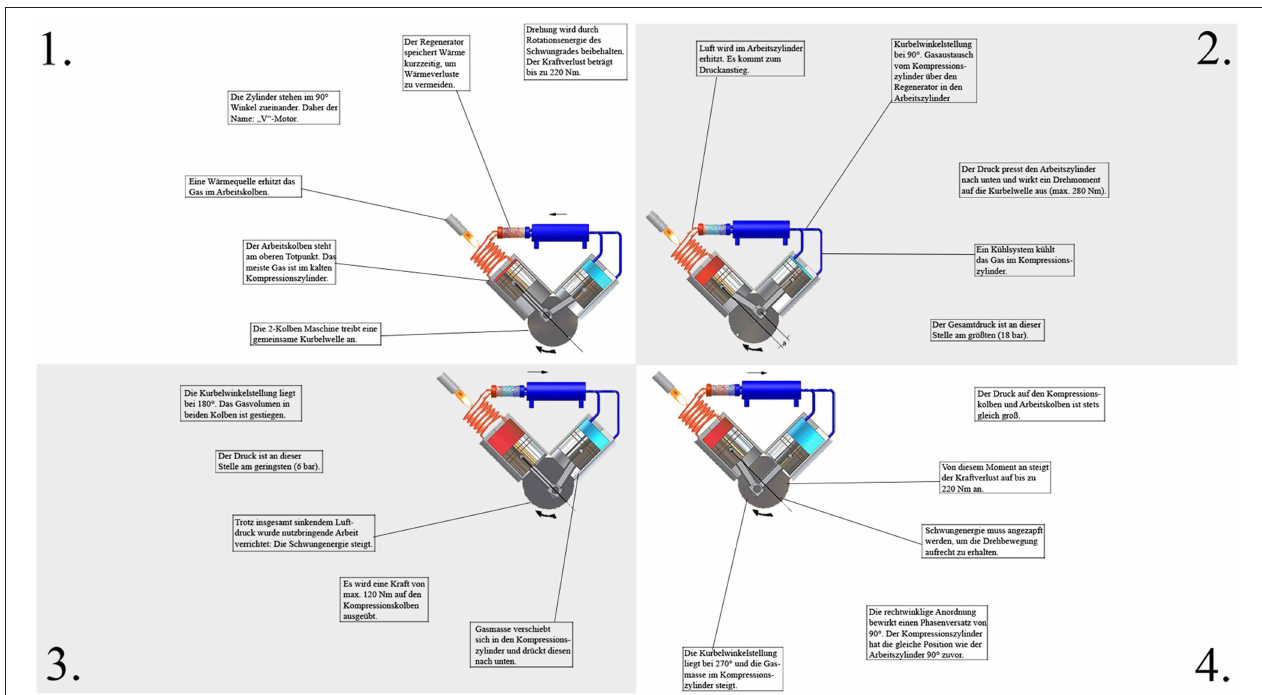
FIGURE 8 | Integrated text-picture presentation with low spatial proximity in Experiment